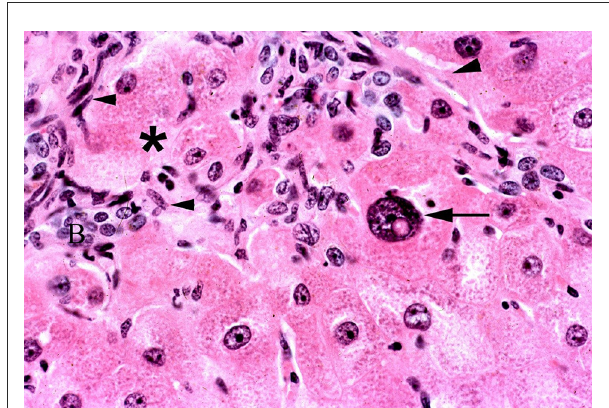
FIGURE11 Photomicrograph of a liver biopsy from horse treated with ground, dried hounds tongue ( Cynoglossum officinale) to obtain a dose of 5mg total dehydropyrrolizidine alkaloids/kg BW for 10 days and allowed to recover for 45 days. Notice the fibroblast proliferation that entraps hepatocytes that are swollen and degenerative (*). One large megalocyte is also present with a large nucleus and prominent nuclear vacuole (arrow). There is also oval cell proliferation (arrowheads) and increased small biliary structures. Figure modified from previous publication (119).